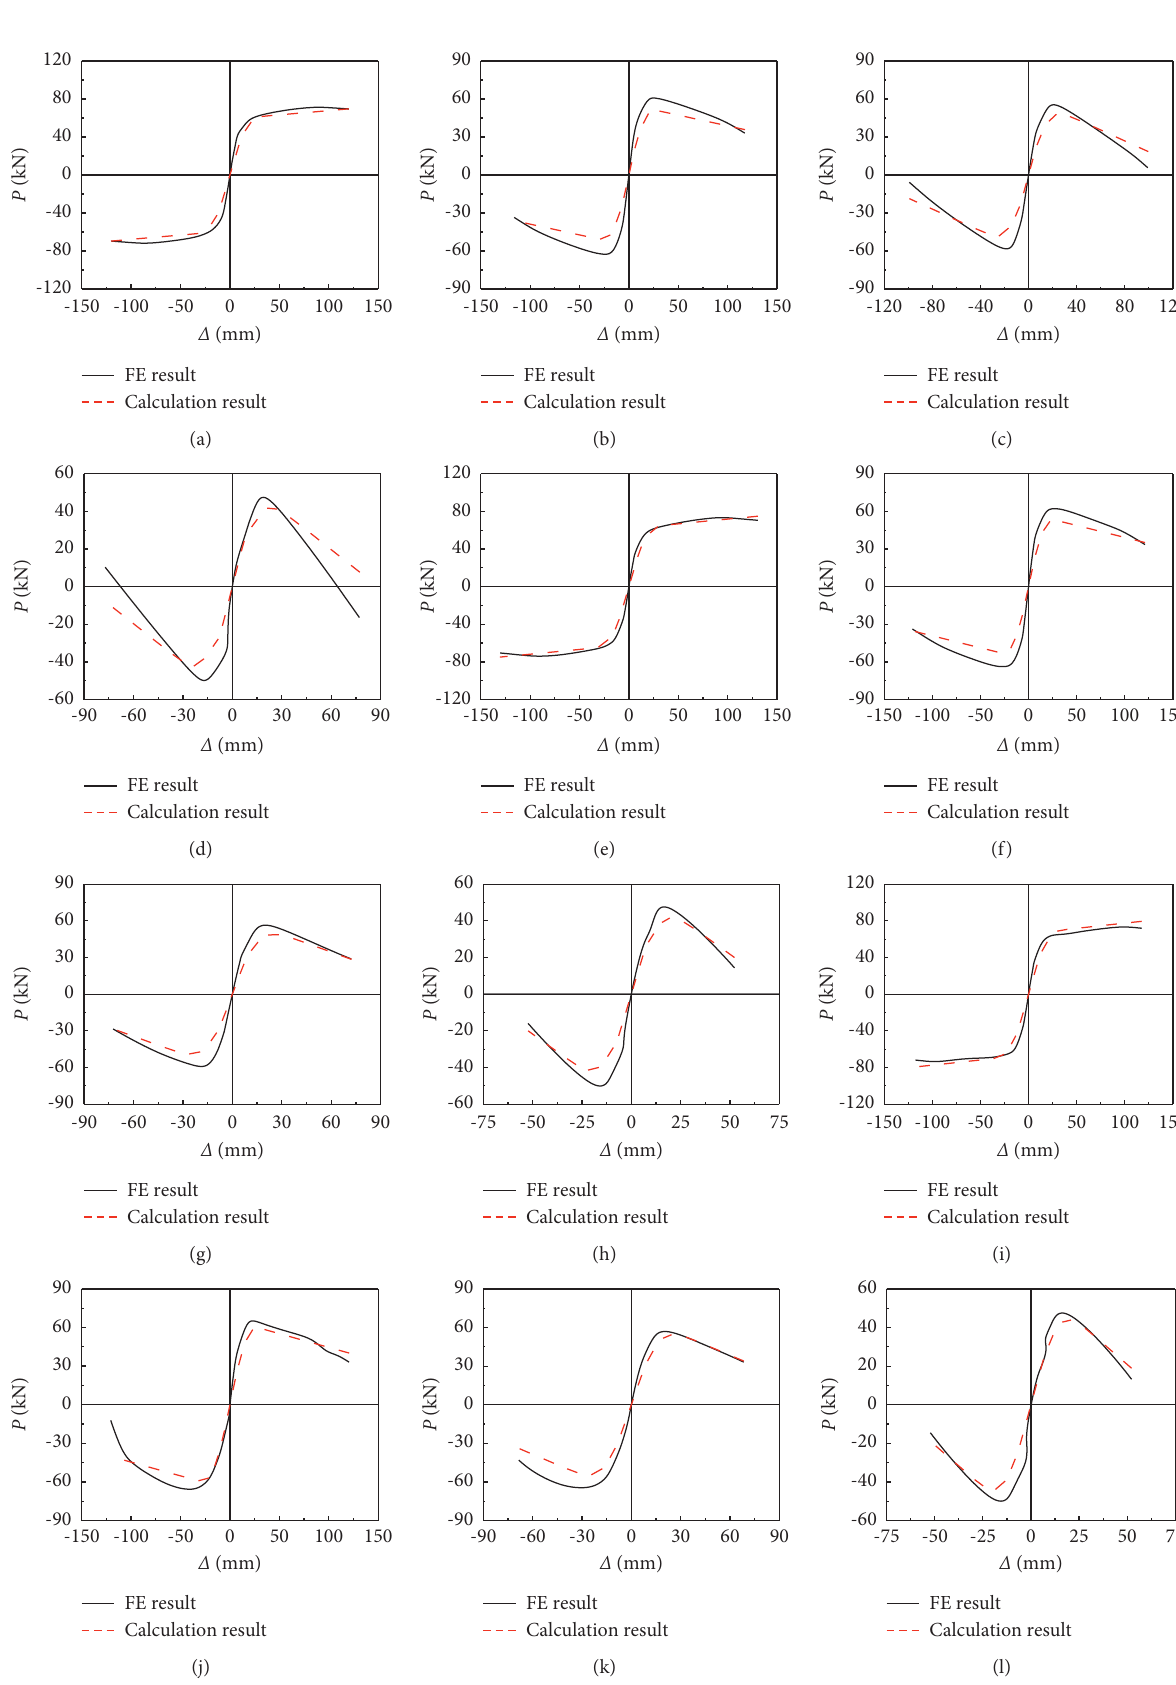
Figure 24: The comparison between the restoring force model’s results and the finite element simulation results of skeleton curve. (a) A0 specimen. (b) B0 specimen. (c) C0 specimen. (d) D0 specimen. (e) A1 specimen. (f) B1 specimen. (g) C1 specimen. (h) D1 specimen. (i) A2 specimen. (j) B2 specimen. (k) C2 specimen. (l) D2